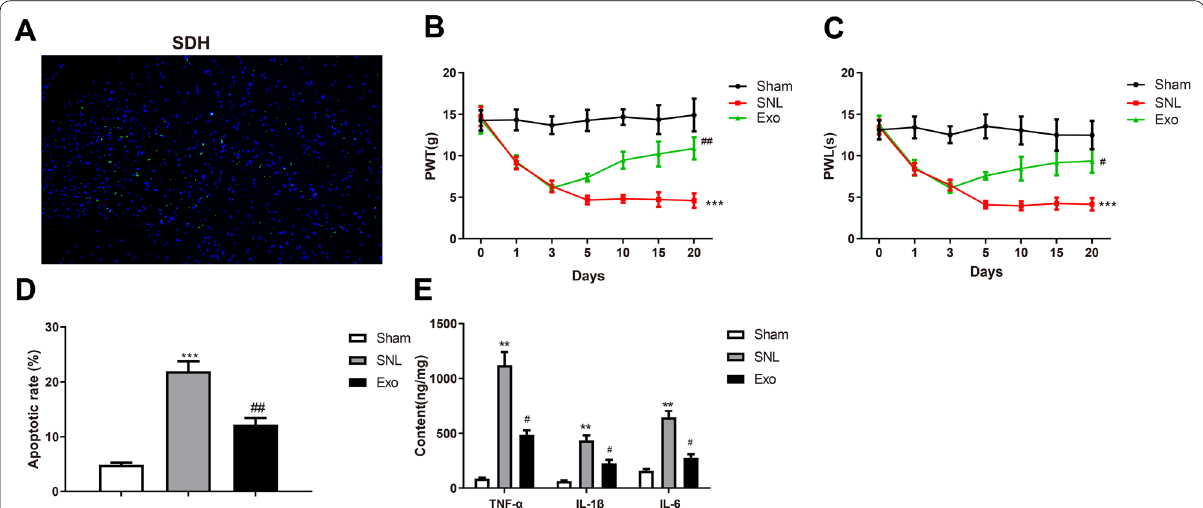
Fig. 2 BMSC-exosomes reduce mechanical allodynia of L5 SNL rats. A Localization of BMSC-exosomes by fluorescence staining; Hind paw PWT ( B ) and PWL ( C ) of SNL rats on days 0, 1, 3, 5, 10, 15, and 20 after surgery; ( D ) TUNEL staining assessed the apoptosis in rat SDH; ( E ) ELISA measured the expression of TNF-α, IL-1β, and IL-6 in rat SDH. Data were shown as mean SNL group. BMSC bone marrow mesenchymal stem cell, SNL spinal nerve ligation, PWT paw withdrawal threshold, PWL paw withdrawal latency, SDH spinal dorsal